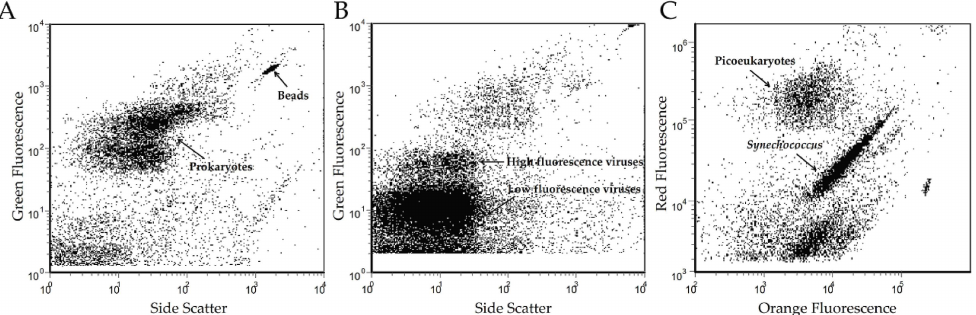
Figure 1. Cytometric plot graph of bacterioplankton ( A ), virioplankton ( B ) and picophyplankton ( C ) populations of sample from the JRE.